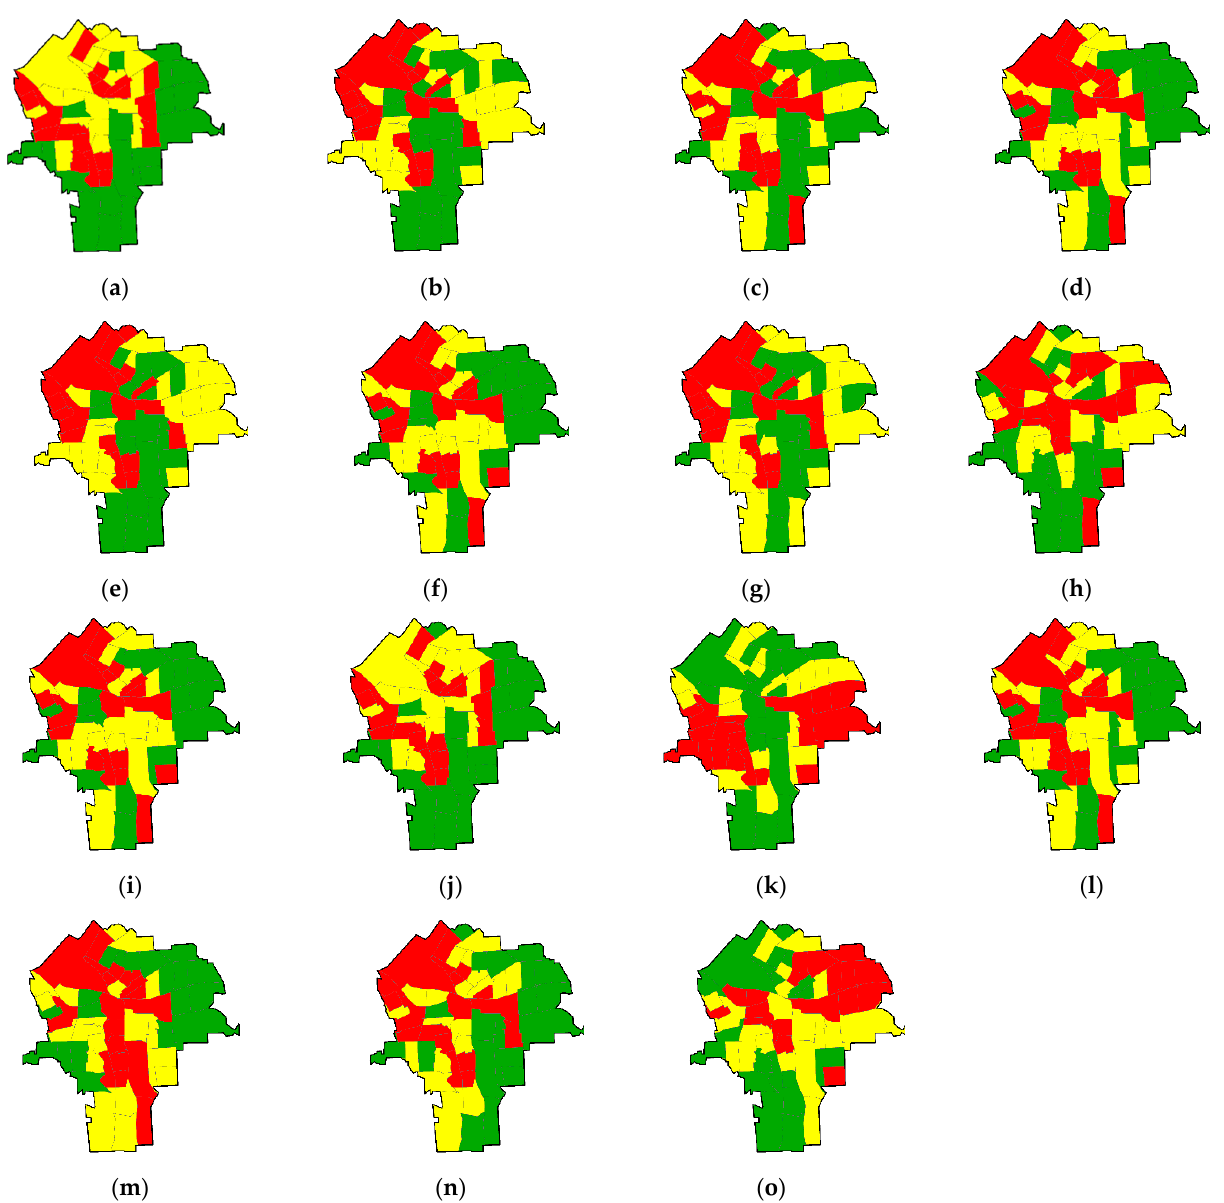
Figure 3. Tertile choropleth maps portraying the 15 trace metal analytic measurement error geographic distributions (census tract resolution): ( a ) As, ( b ) Cr, ( c ) Co, ( d ) Cu, ( e ) Fe, ( f ) Pb, ( g ) Mn, ( h ) Hg, ( i ) Mo, ( j ) Ni, ( k ) Rb, ( l ) Se, ( m ) Sr, ( n ) Zn, and ( o ) Zr; red denotes relatively high errors, yellow denotes moderate errors, and green denotes relatively low errors.